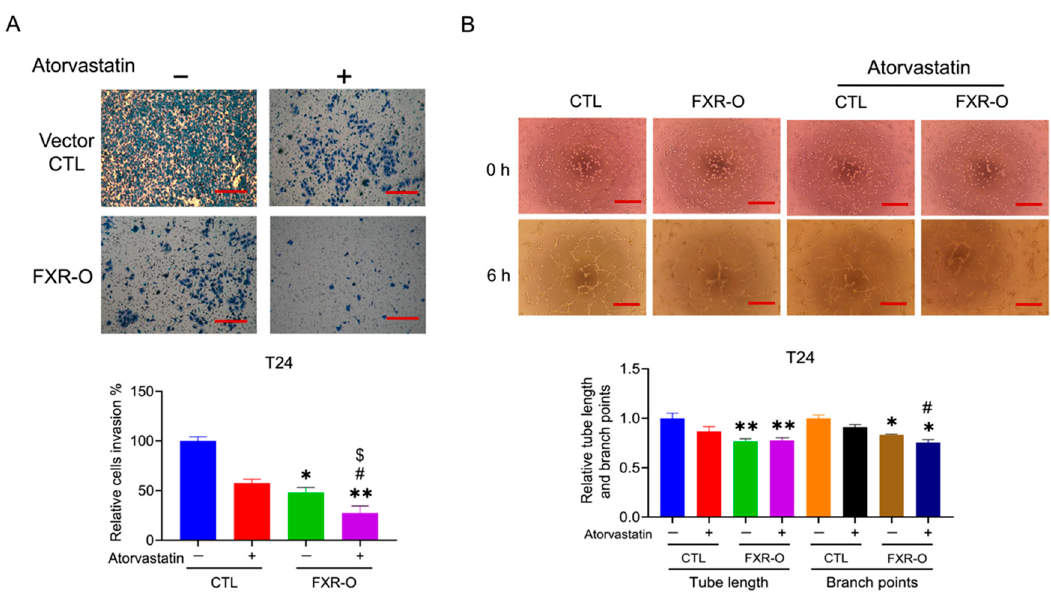
Figure 7. The effect of FXR overexpression combined with atorvastatin treatment on the invasion and angiogenesis of T24 cells. ( A ) Transwell invasion assays were performed in control and FXR-O T24 cells treated with or without atorvastatin. The lower panel shows the relative migration rate. ( B ) Tube formation assays were performed in control and FXR-O T24 cells treated with or without atorvastatin. The number of branch points and tube length of endothelial cell networks were analyzed. The quantitative results of the analysis of relative branch point numbers and tube lengths were shown below. * p < 0.05; ** p < 0.01; compared to the control group. # p < 0.05 compared to the control + atorvastatin group. $ p < 0.05 compared to the FXR-O group. Scale bar = 200 µ m.